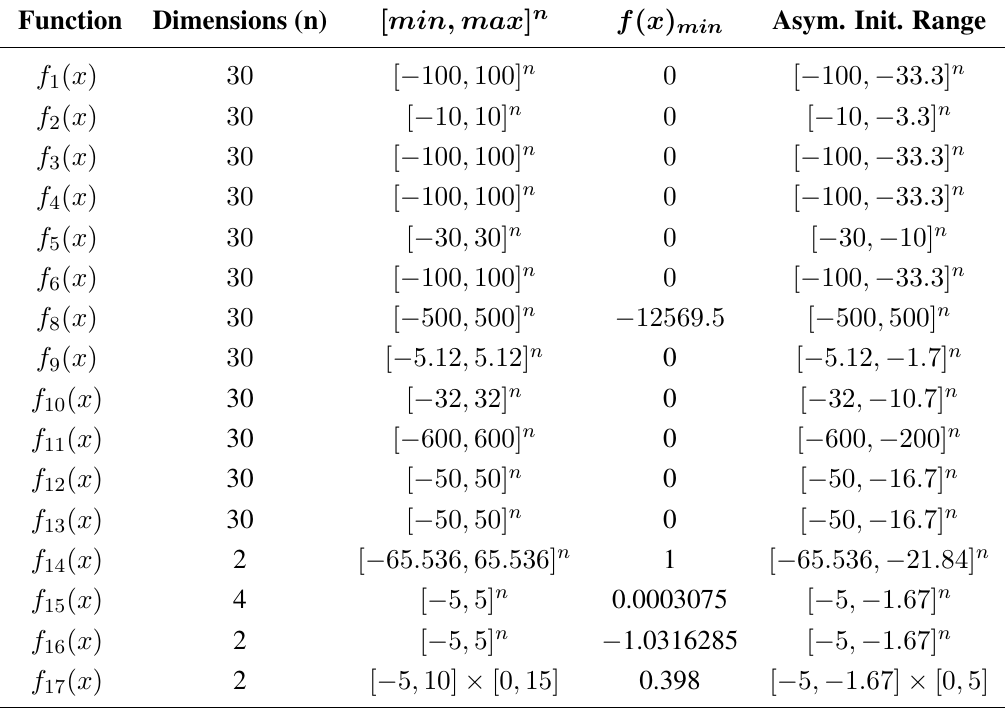
Table 1. Benchmark